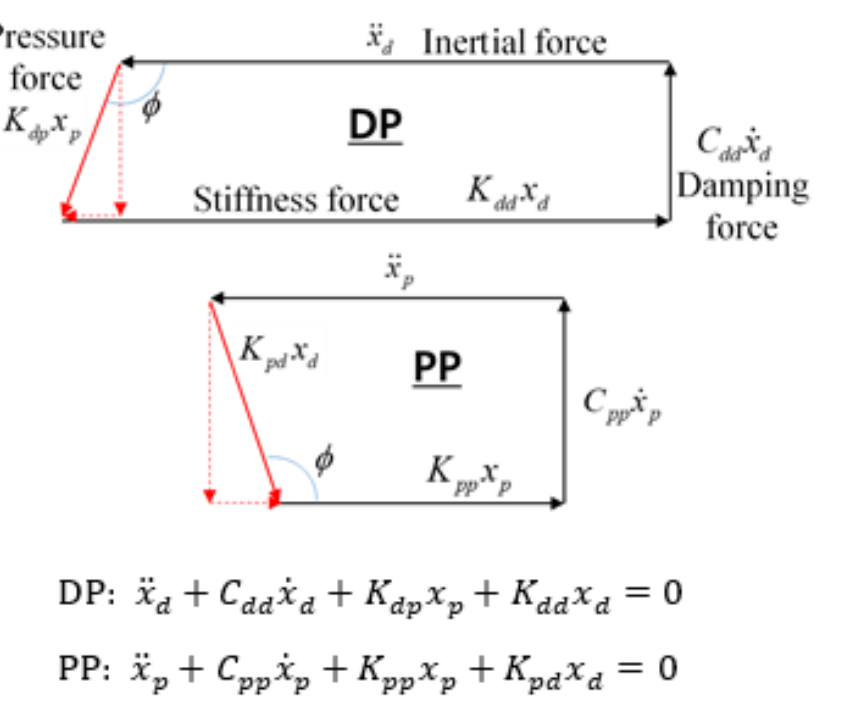
Figure 12. Force vector diagrams for the DP and PP, based on the linearized EOM in Equation (7). pressure stiffness force caused by the other piston displacement. Therefore, the phase angle between the excitation force and piston displacement becomes identical to the DP–PP phase